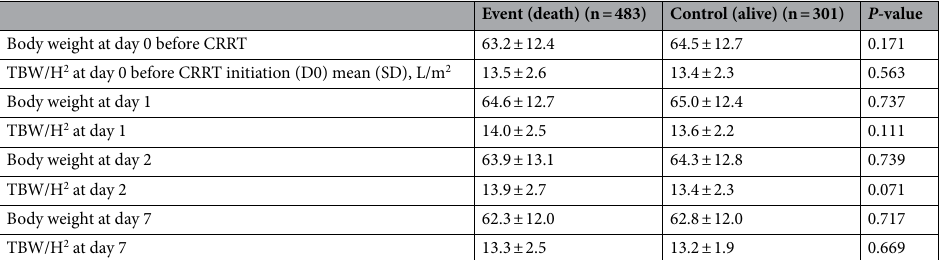
Table 3. Volume status assessments using BCM during CRRT. Continuous variables are presented as means (standard deviations) and categorical variables as frequencies (percentages). CRRT, continuous renal replacement therapy; TBW/H 2 , total body water/height 2 (L/m 2